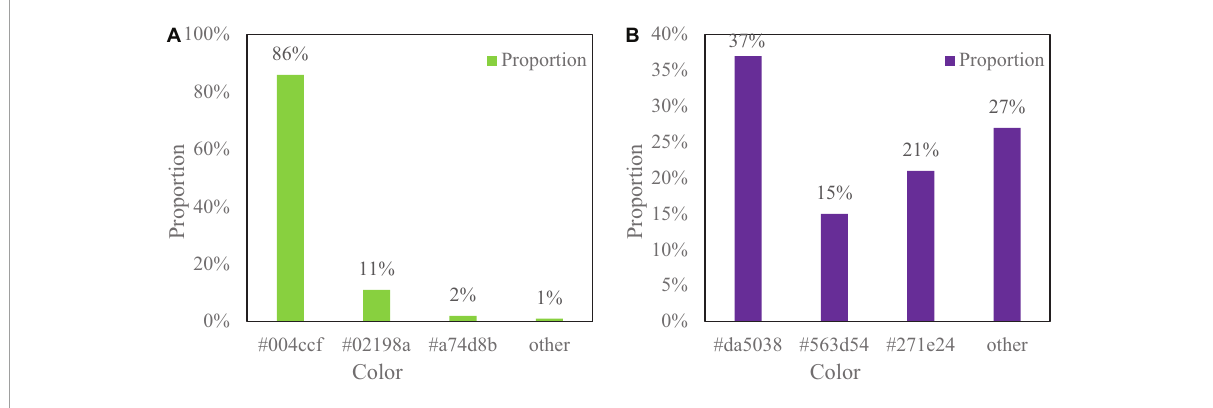
FIGURE7 The proportion of different clothing colors. (A) Shows that blue with the color number #004ccf has the largest proportion. (B) Shows that the red with the color number #da5038 has the largest proportion, followed by the purple color of #563d54 and the color number #271e24 also occupy a certain proportion. The main colors extracted from this are #004ccf, #973f37, #563d54, and #271e24.